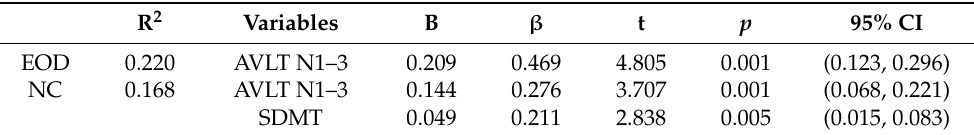
Table 4. Multiple linear regression analyses of the association between OI and cognitive function in EOD and NC